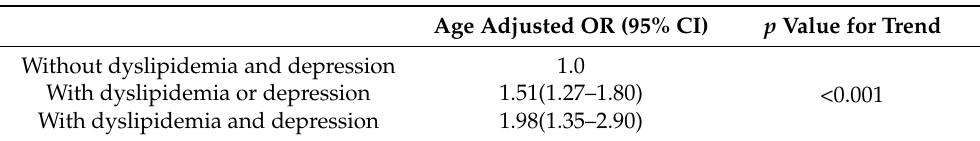
Table 7. Logistic regression analysis of osteoporotic subjects with dyslipidemia and/or depression adjusted by